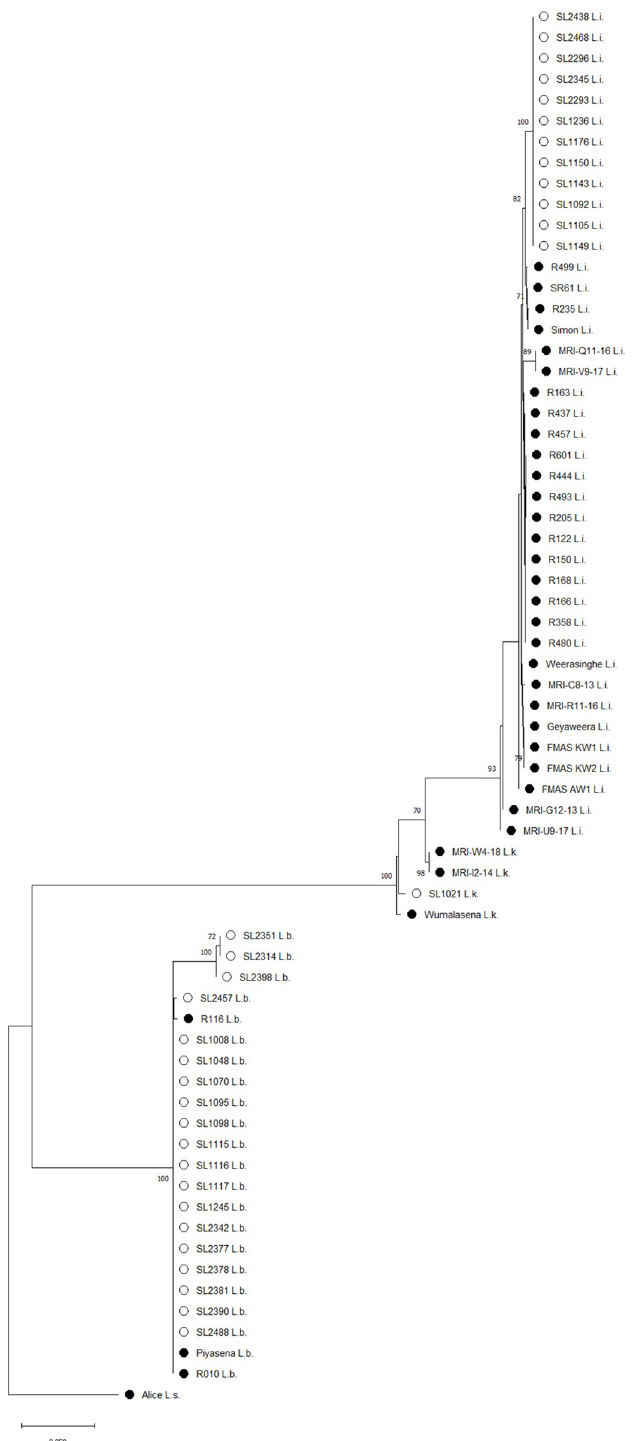
Fig 5. Evolutionary analysis of concatenated MLST allele sequences The tree was inferred in MEGA X using the Maximum Likelihood method and Tamura 3-parameter model. Bootstrap values above 70% are shown next to the branches. MLST sequences from Leptospira interrogans (L.i.), Leptospira borgpetersenii (L.b.) and Leptospira kirschneri (L.k.) obtained from specimen collected in this study are shown ( � ). For comparison, MLST sequences from human clinical isolates originating from Sri Lanka were included in the analysis ( ● ). The tree was rooted using concatenated MLST sequences of Leptospira santarosai (L.s.) strain Alice.